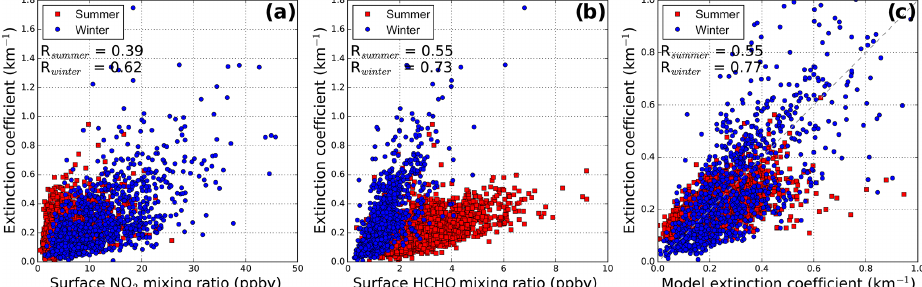
Figure 6. Panel (a) shows the correlation between surface aerosol extinction coefficients ( ε surf ) and NO 2 mixing ratios. Panel (b) shows the correlation between ε surf and HCHO mixing ratios. Panel (c) shows the scatterplot of measured and modeled surface aerosol extinction coefficients. Data measured in summer (June, July and August, red markers) and winter (December, January and February, blue markers) are